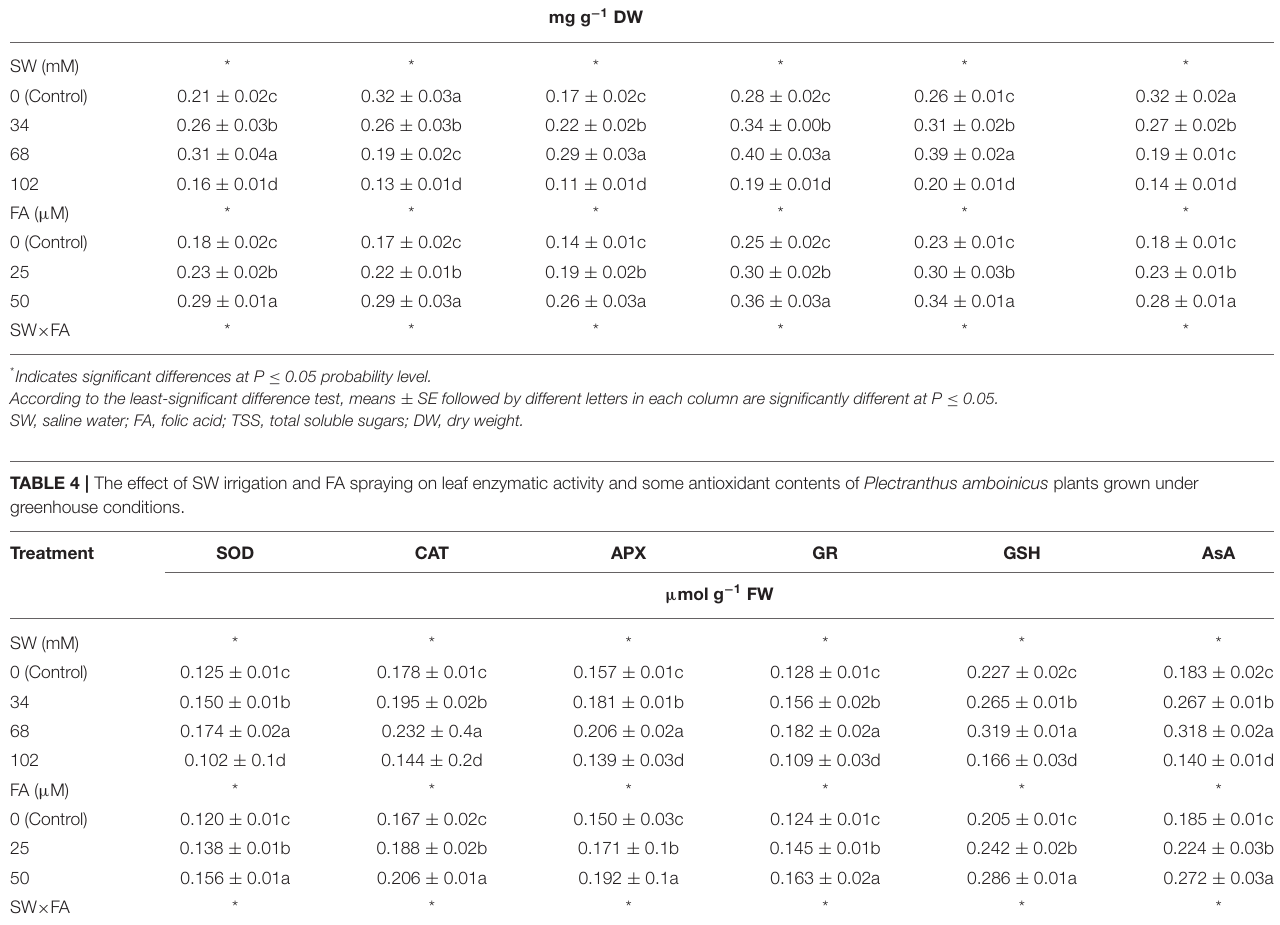
SW, saline water; FA, folic acid; SOD, superoxide dismutase; CAT, catalase; APX, ascorbate peroxidase; GR, glutathione reductase; GSH, glutathione; AsA, ascorbic acid; FW, fresh